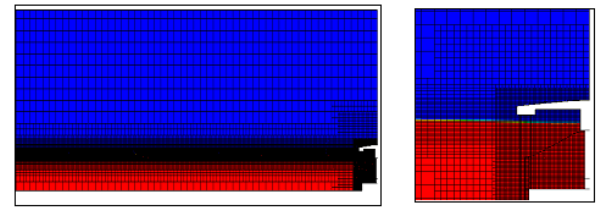
Figure 14. General domain grid and grid detail around the absorb- ing quay wall